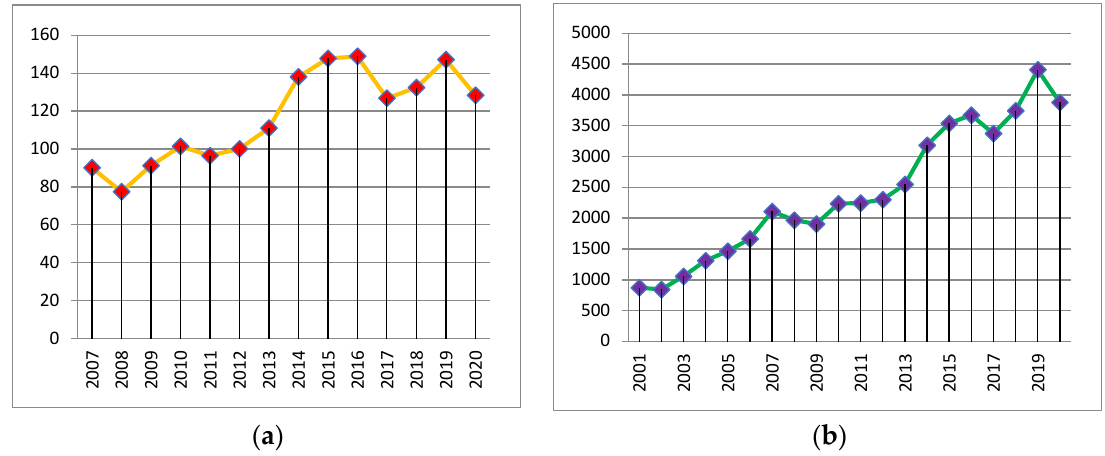
Figure 3. ( a ) Evolution of implicit tax rate on energy (ITR); and ( b ) evolution of environmental tax revenues from energy taxes (RET).